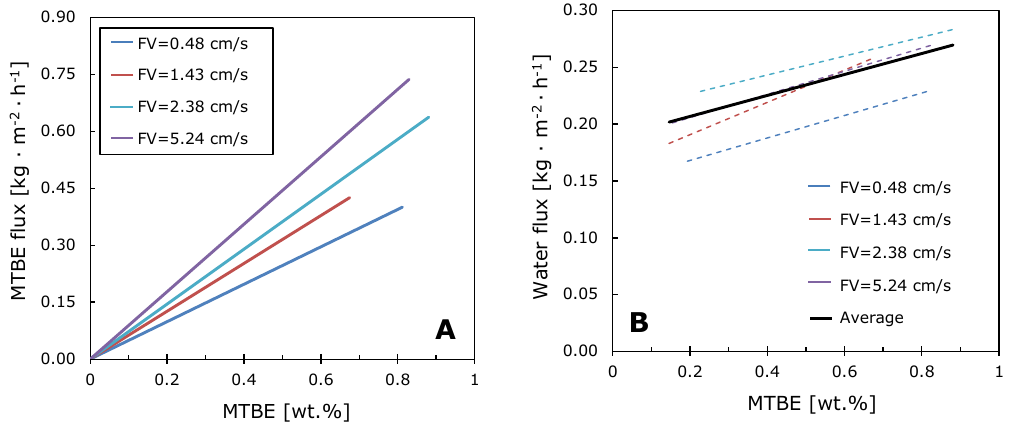
Figure 8. The dependences of MTBE ( A ) and water ( B ) fluxes on MTBE concentration and linear velocity of the feed solution. T = 50 ◦ C. FV–flow velocity.